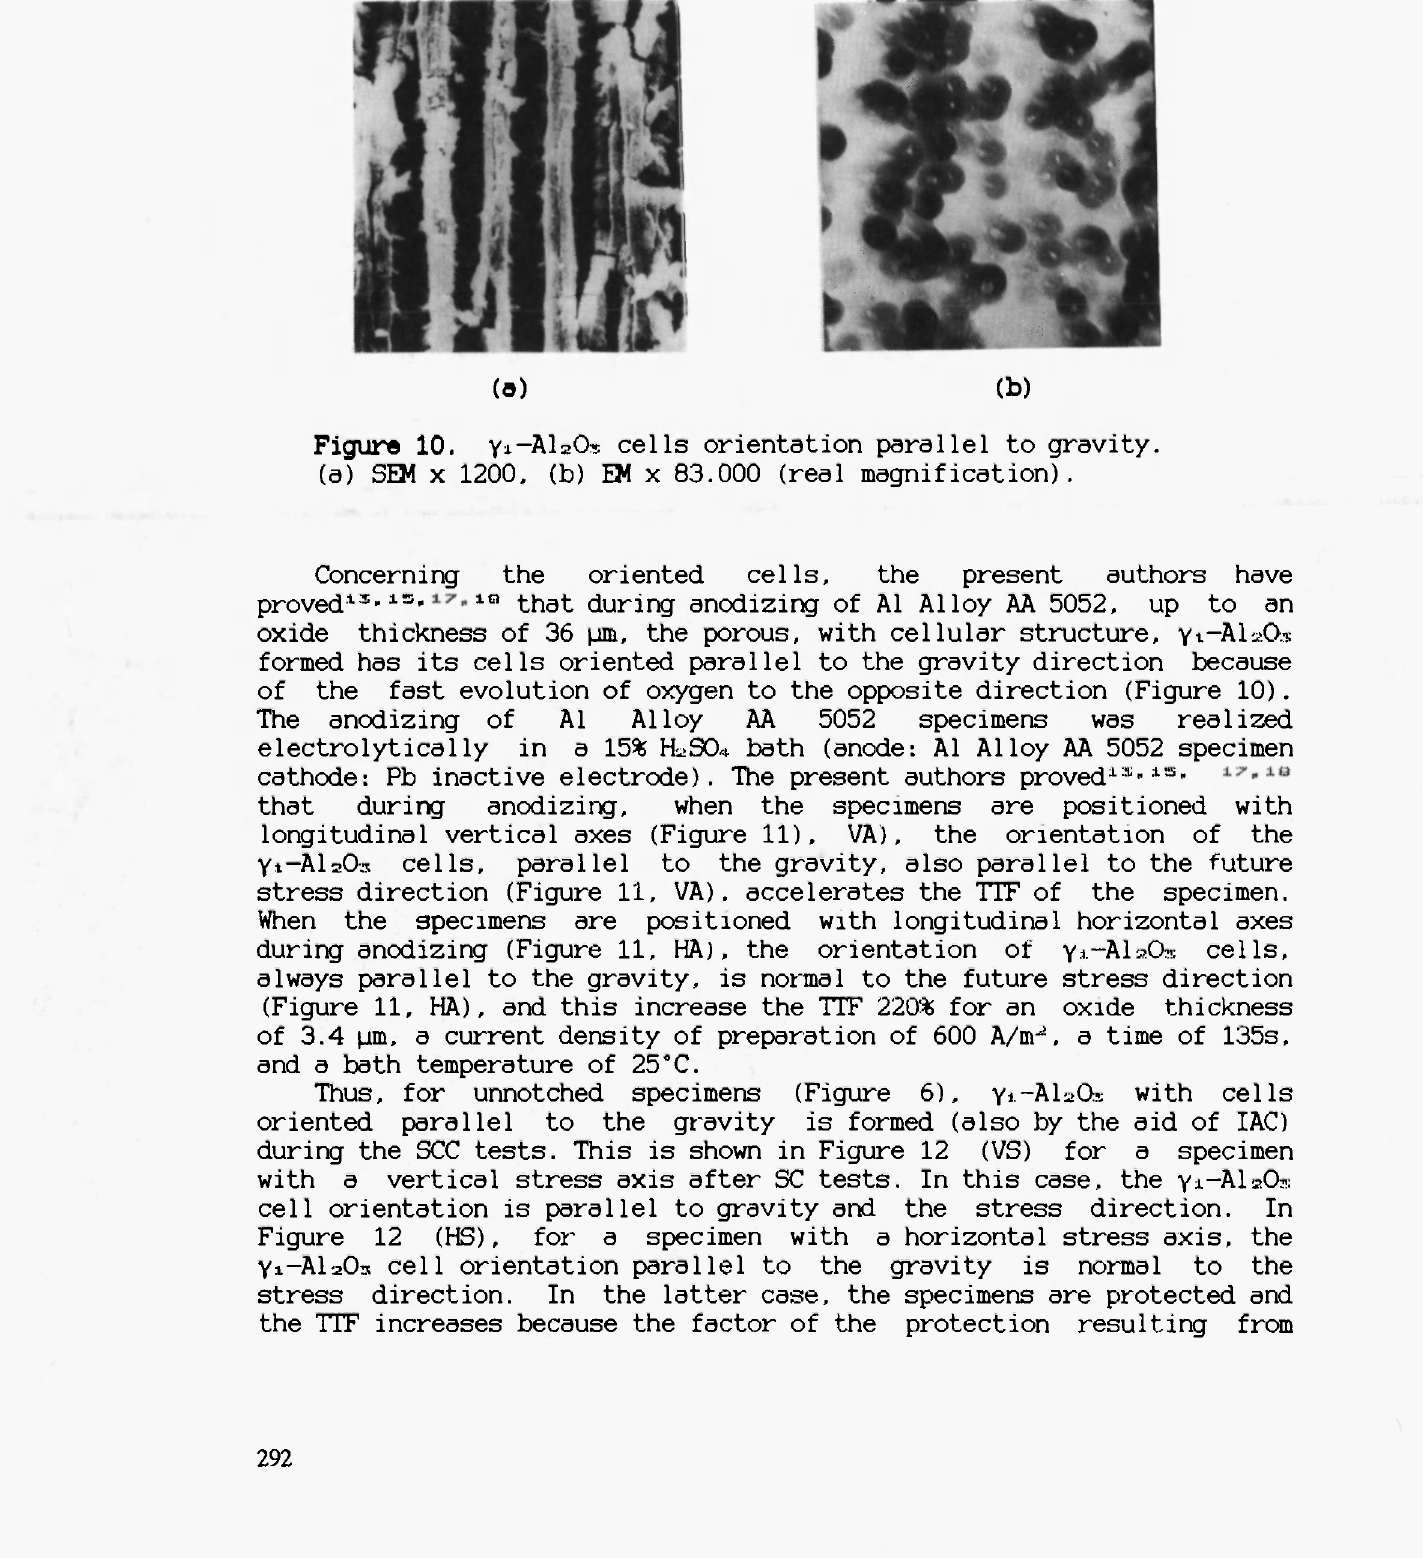
Figure 10. Υι-ΑΙβΟϊ cells orientation parallel to